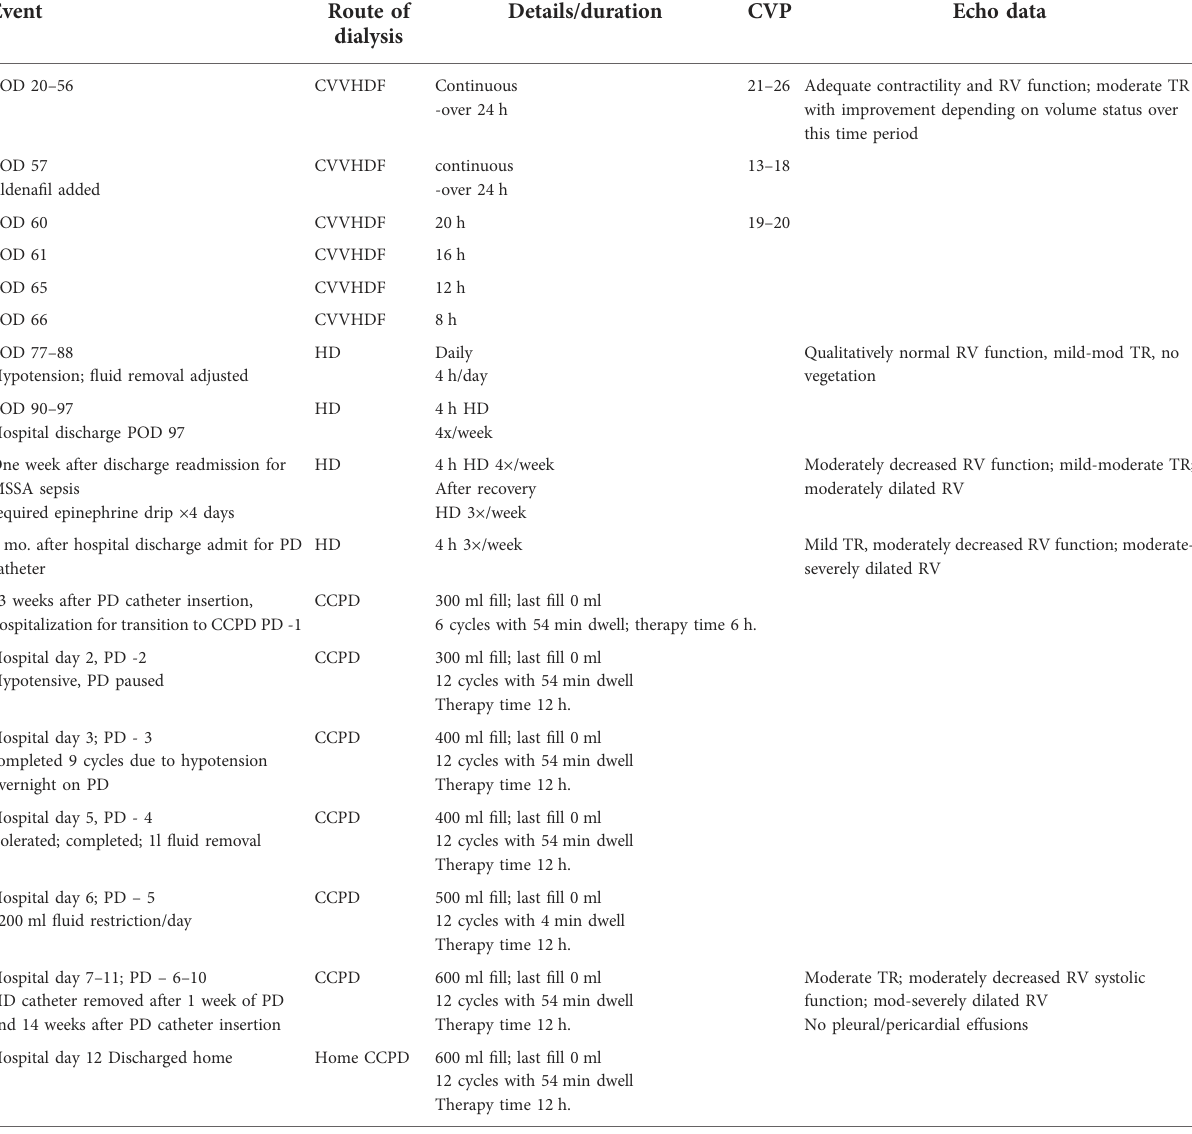
TABLE 1 Details outlining transition between modes of